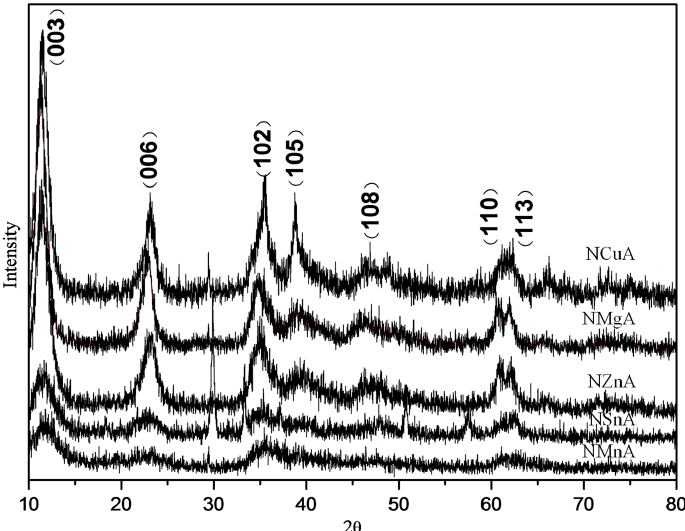
ff erent precursors derived from Figure 1. XRD patterns of different precursors derived from hydrotalcite. Figure 1. XRD patterns of di